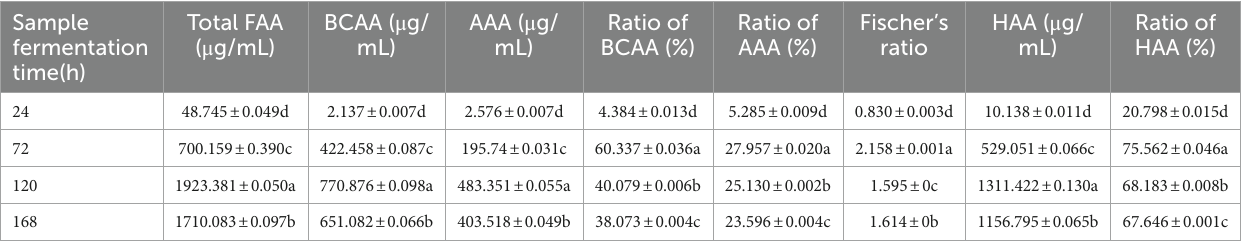
TABLE 1 Changes of various amino acids at different fermentation